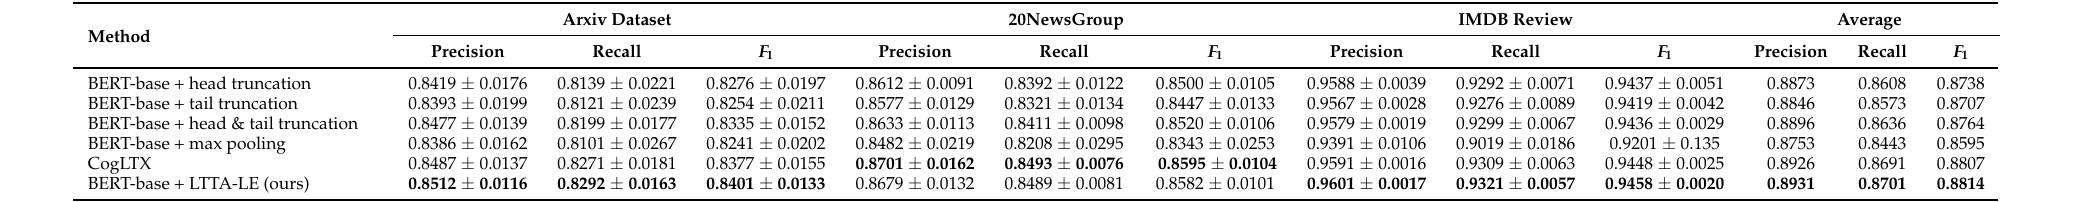
Table 2. Experimental results on different datasets ( ± indicates standard deviation).